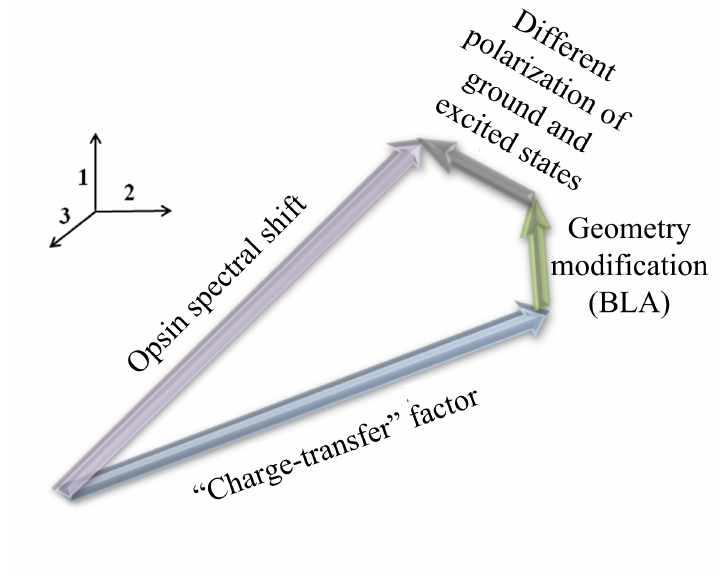
Figure 12. The electrostatic spectral tuning mechanism in rhodopsins involves three main factors: 1. The “charge transfer” factor related to difference in charge distributions of ground and excited states of the PSB. The positive charge partially translocates from the NH region to the β -ionone ring region upon photoexcitation. Therefore, ground and excited states of the chromophore possess different interactions with external charges. 2. The modification of the bond length alternation (BLA) of the chromophore by the external electrostatic field. 3. Differences in polarization of the ground and excited states of the PSB by the external electrostatic